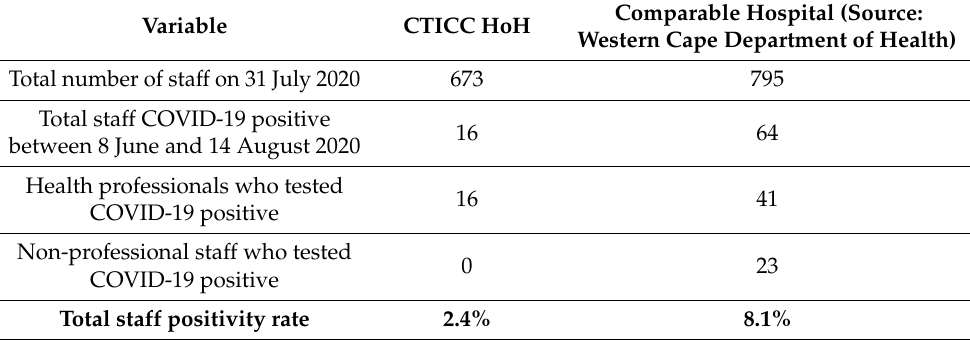
Table 3. Staff infections with